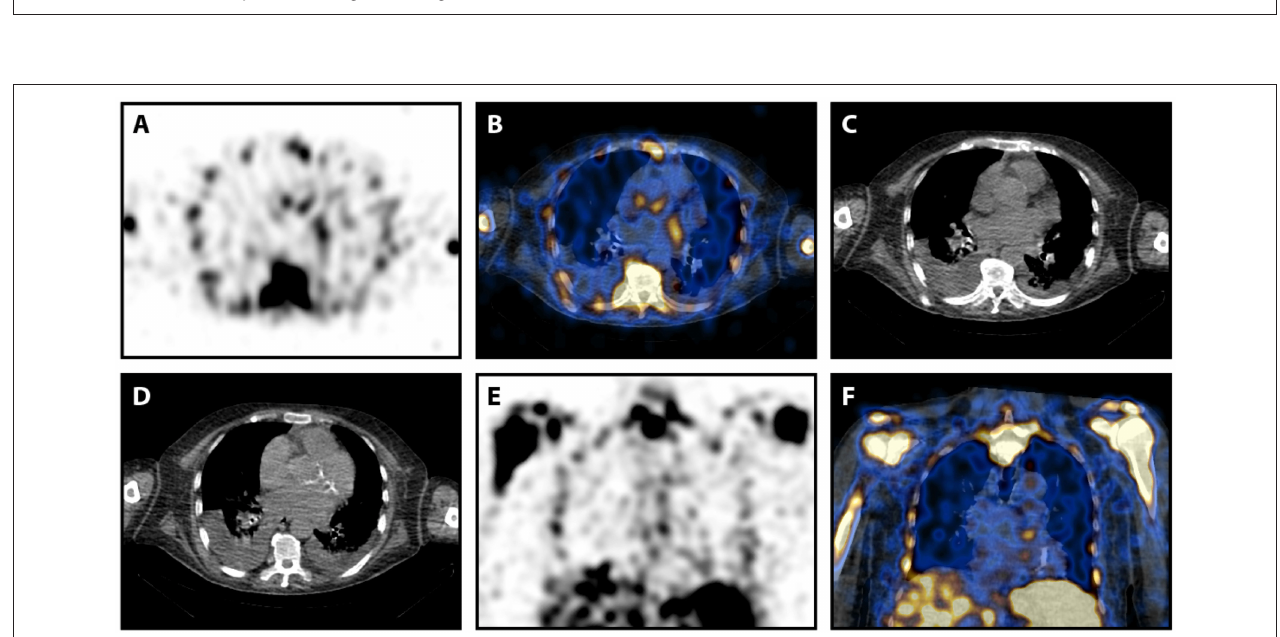
FIGURE 2 | 99m Tc-Besilesomab-SPECT/CT in a patient with suspected prosthetic valve infection and intra-observer difference. Images of a 78-years old male patient with suspected prosthetic valve infection. Blood cultures detected Enterococcus faecalis and TEE was negative. SPECT showed a trifocal uptake at the aortic valve level (A) . This focal uptake was localized slightly cranial of the prosthetic valve in fused images (B) . (C) Non-fused CT image at the same level as (B) . (D) Non-fused CT image of the prosthetic valve caudal of (D) . Focal uptake was also visible in coronal view (E,F) . Observer 1 scored the focal uptake “2” while observer 2 scored it “1.” The patient had a fever above 38 ◦ C for 4 weeks. Clinical inspection detected Osler’s nodes on the hands. Endocarditis was clinically confirmed according to Duke criteria.